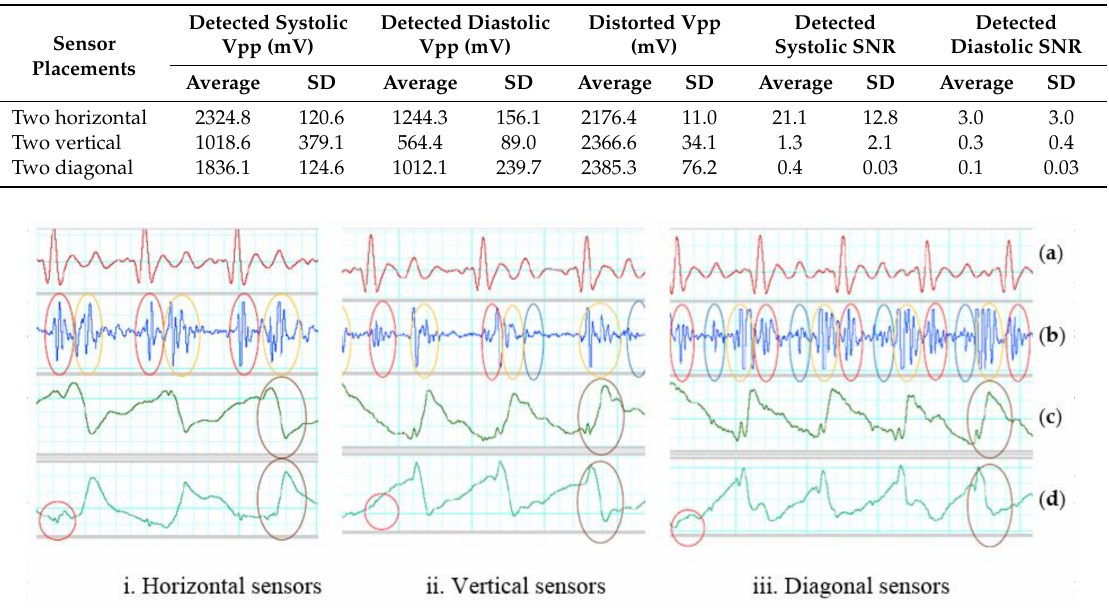
Figure 8. ADDER on gentle motion. ( a ) Filtered ECG (5–20 Hz). ( b ) Filtered SCG (20–50 Hz). Red oval indicates a recognized systole. Blue oval indicates an identified diastoles. ( c ) First sensor z-axis. ( d ) Second sensor z-axis. Red circle indicates a small SCG signal. Table 4. Signal measurements of using two sensors with ADDER on walking motion.